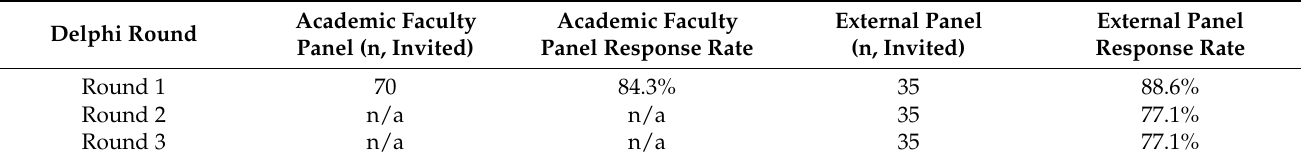
Table 1. Delphi expert panel response